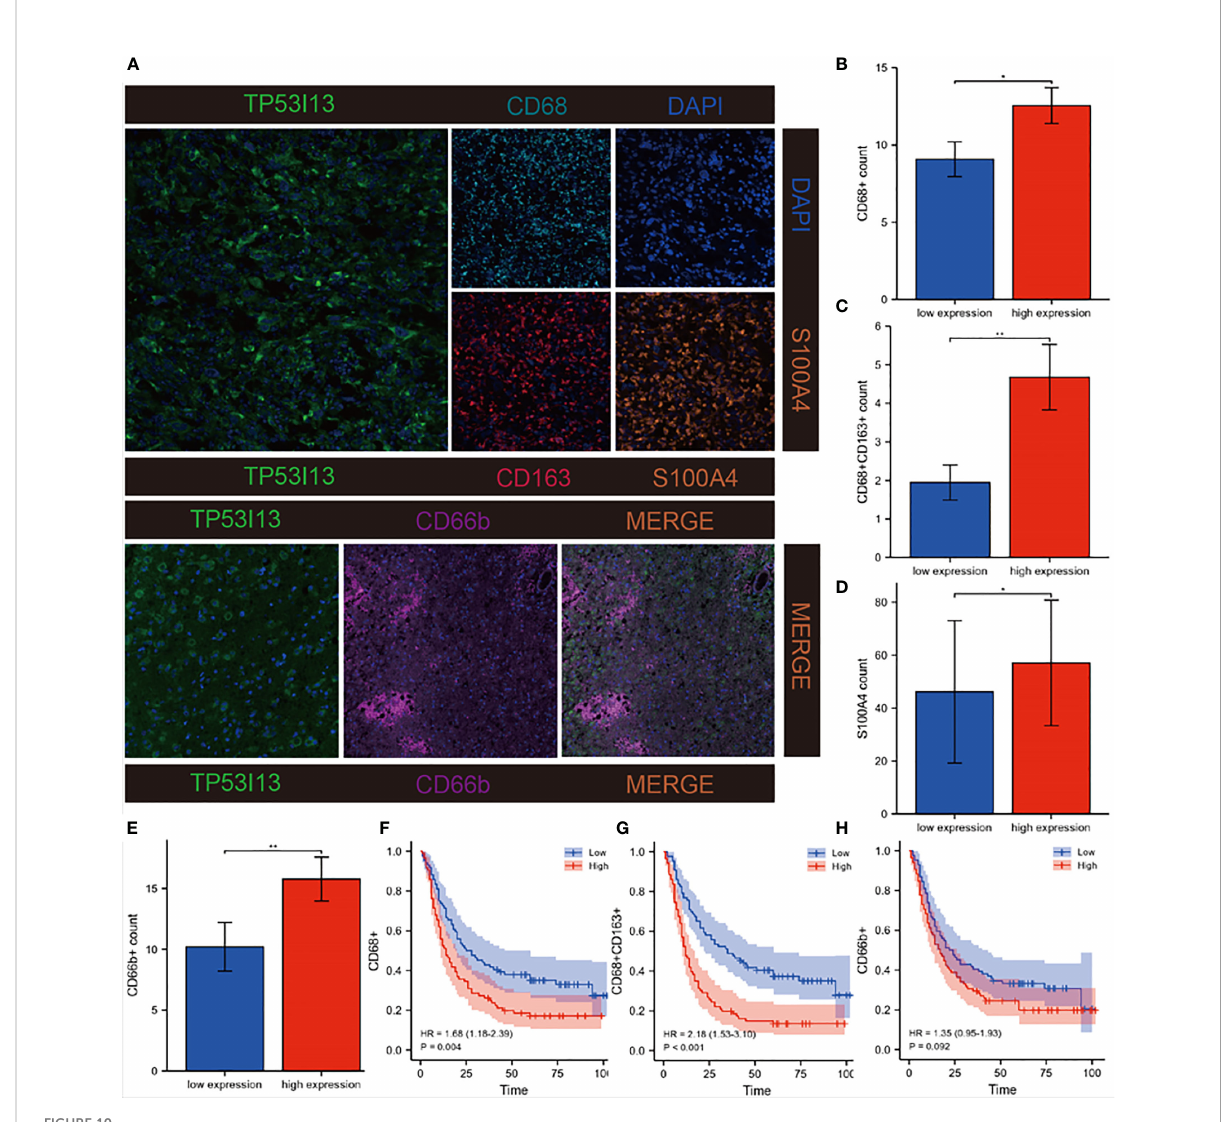
FIGURE 10 Investigation of correlations between TP53I13 and macrophages, neutrophils, and CAFs markers on samples from Nantong University Af fi liated Hospital. (A) mIHC of TP53I13 and different macrophage markers (CD68, CD163), neutrophils marker (CD66b), and CAFs marker (S100A4). (B-E) The relationships between the TP53I13 expression and CD68+, CD68+CD163+, S100A4, and CD66b+. (F-H) Survival analysis of TP53I13 high- and low-expression and CD68+, CD68+CD163+, and CD66b+. *P < 0.05, **P <